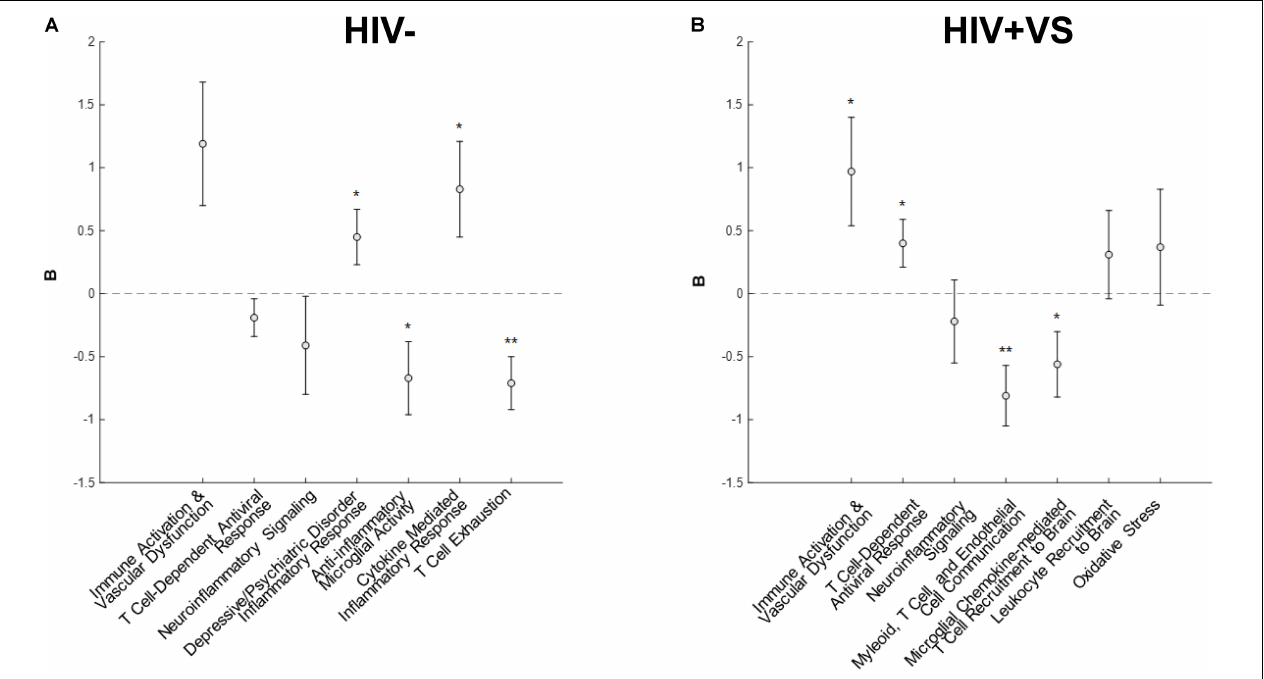
FIGURE 1 | Associations between inflammatory profile scores and global cognitive performance at a subsequent point in time among (A) HIV- uninfected (HIV-) woman and (B) virally suppressed women with HIV (HIV + VS). * p < 0.05; ** p < 0.01. Circles denote the unstandardized beta weights (B) and standard errors of (B) . Circles above 0 indicate positive associations whereas circles below 0 indicate negative associations. Inflammatory signatures highlighted in gray are common to both HIV– and HIV+ VS women whereas inflammatory signatures not highlighted in gray are specific to either HIV– or HIV+ VS